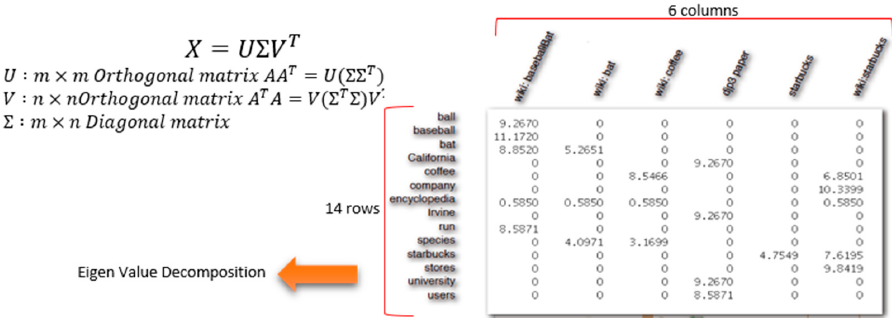
Figure 1. Example of Singular Value Decomposition (SVD).